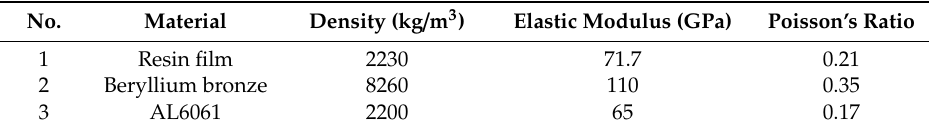
Figure 5. The selection of the materials. Table 1. The material parameters.